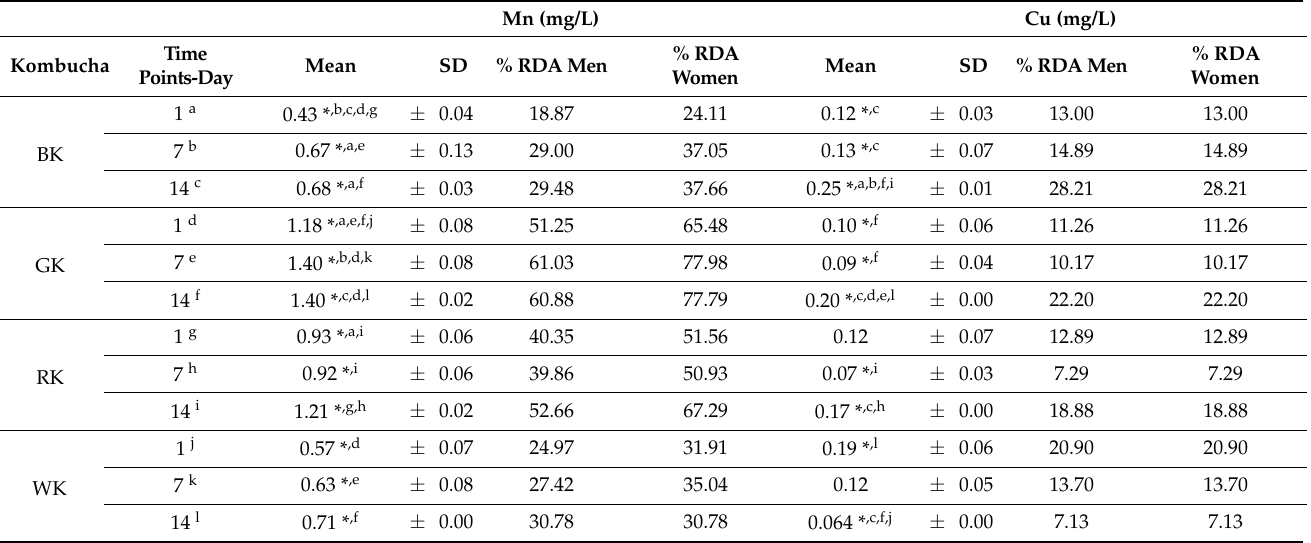
Table 2. The microminerals content (Mn, Cu) and Recommended Dietary Allowances (RDA) in Kombucha. Mn (mg/L) Cu